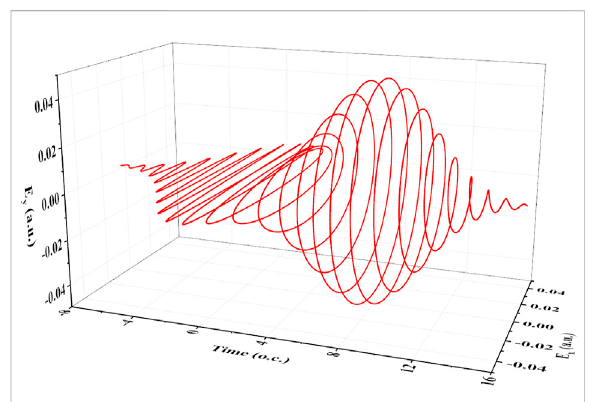
FIGURE 1 The electric fi eld form of the laser fi eld pulse combined with linearly polarized and circularly polarized laser of the time delay Δ T = 8